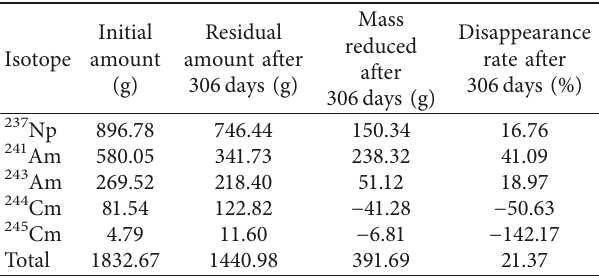
Figure 21: The k-inf versus burnup when coating a thin layer of MAs to the UGD pins and reducing GD to 3.0wt.%. Table 5: Transmutation rate in case of heterogeneous loading with 10wt.% of